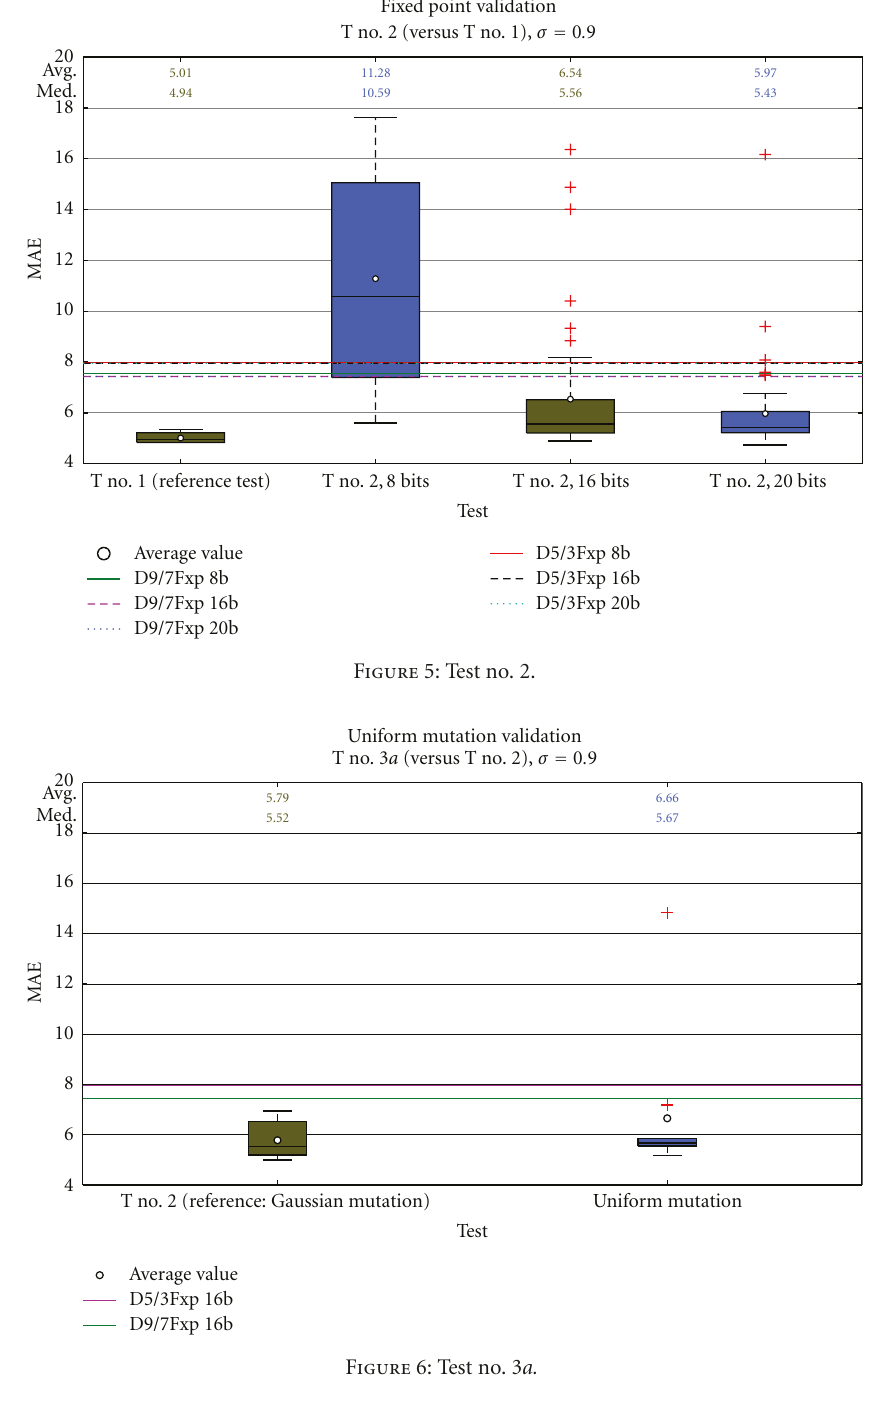
Figure 5: Test no. 2.